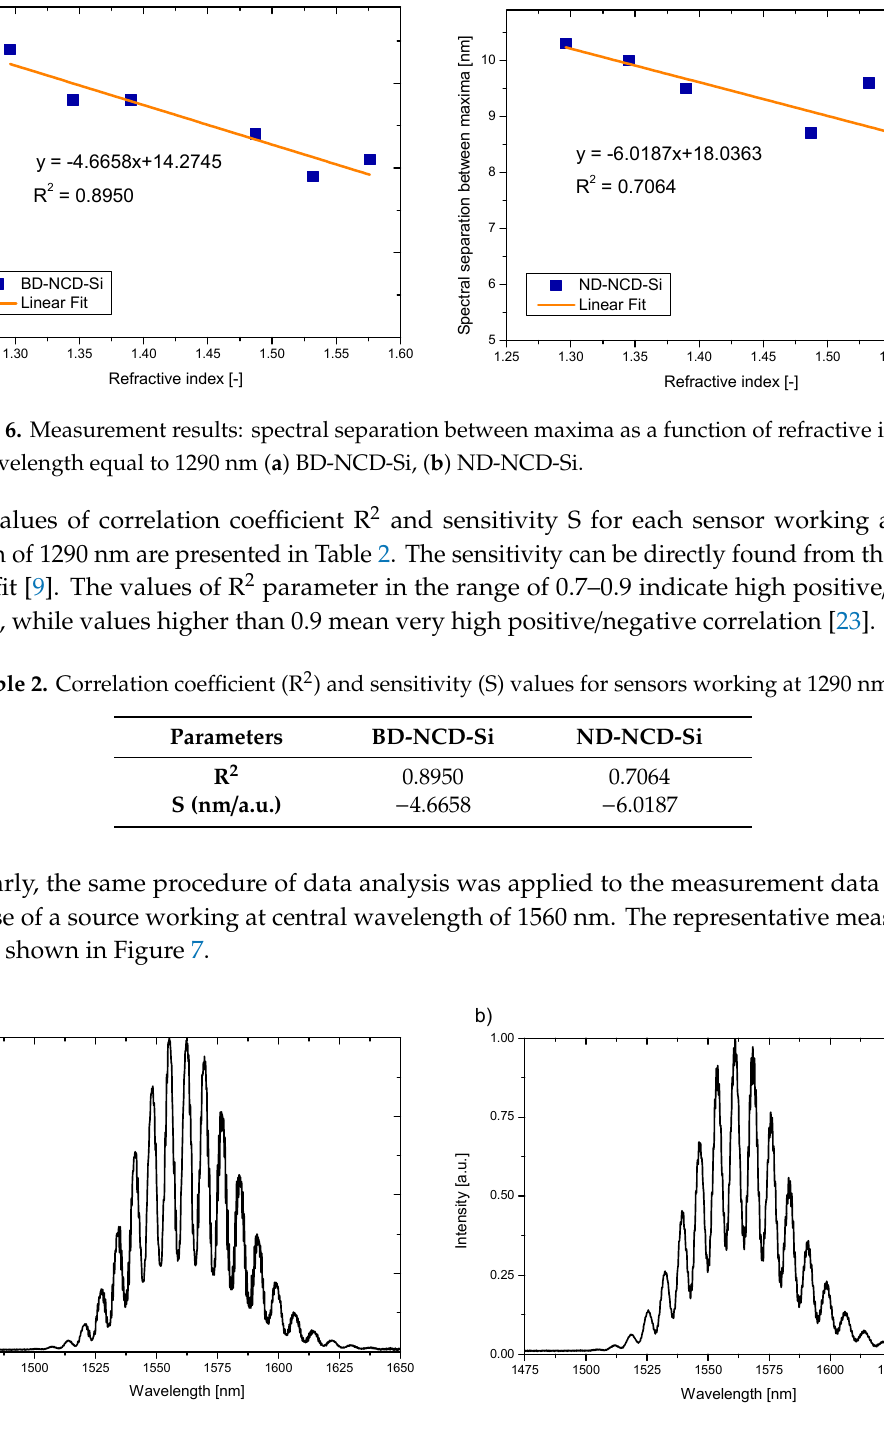
Figure 7. Spectra of liquid with refractive index n = 1.6 measured with a wavelength of 1560 nm ( a ) BD-NCD-Si, ( b ) ND-NCD-Si.